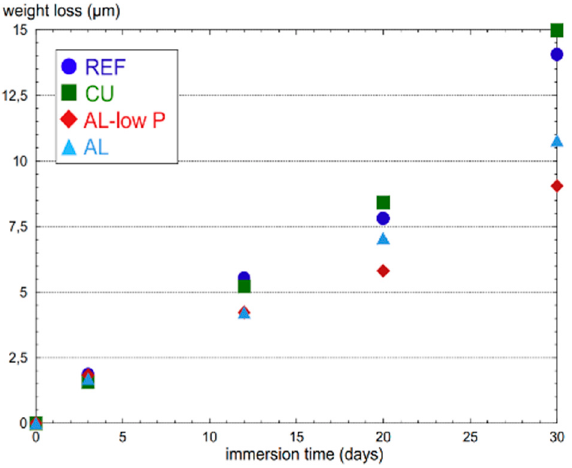
Figure 14. Weight loss versus time for Fe-18Mn-0.6C-0.032P exposed to 5 wt.% NaCl [98]. (Repro- duced with permission from refs. [98] . Copyright (2014 ), Elsevier).